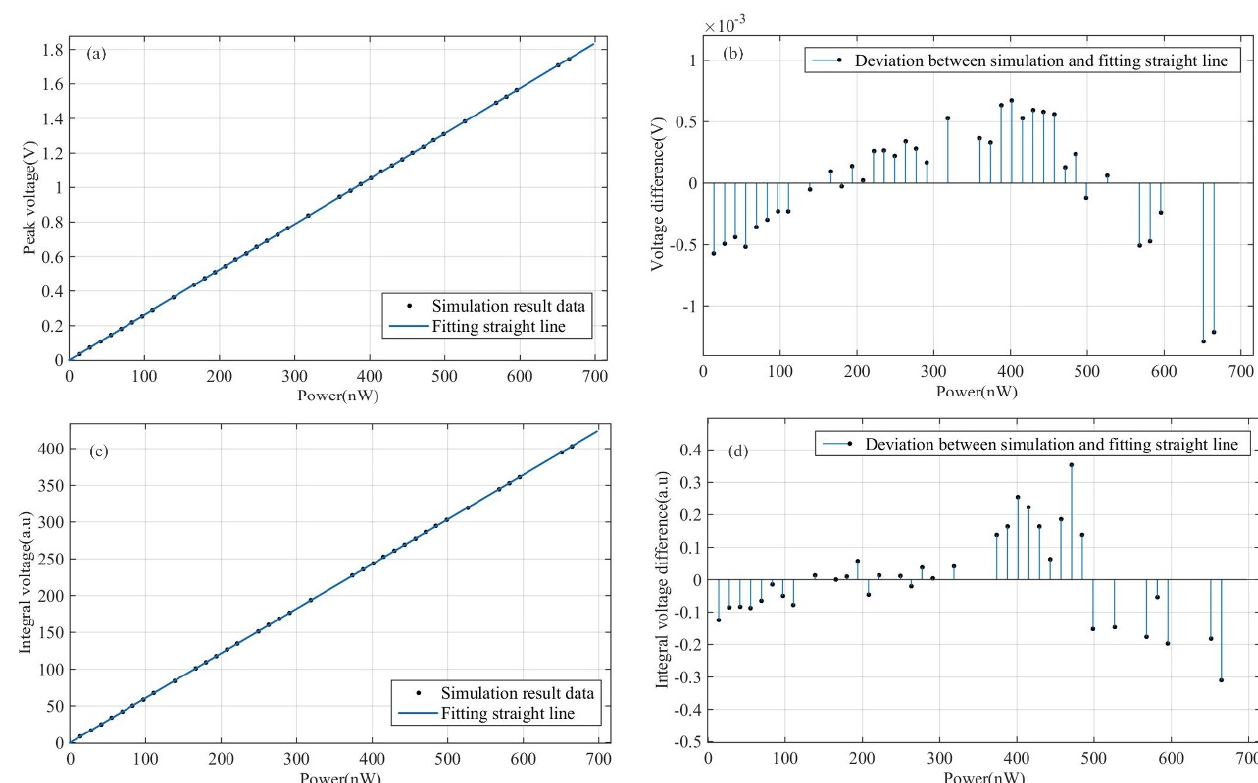
Figure 11. ( a ) The simulation of the optimized ACB at magnification of 10. ( b ) The green line is the input signal and the red line is the output signal.